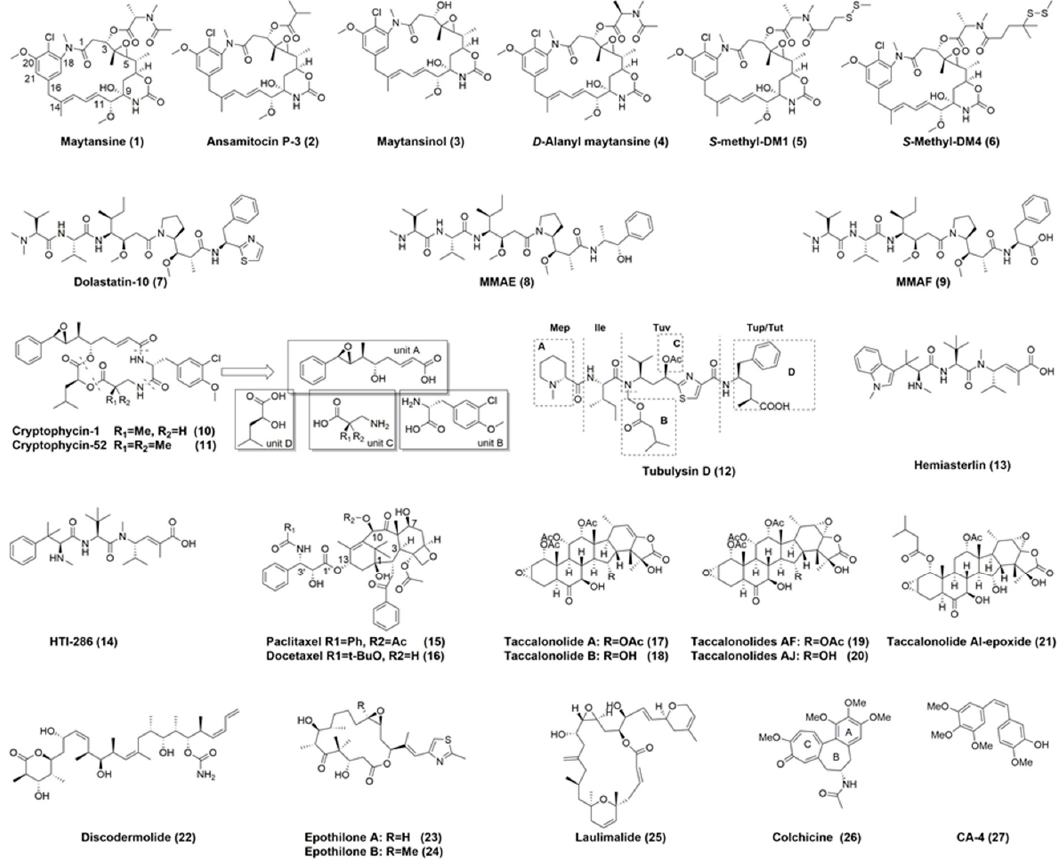
Figure 5. The chemical structures of tubulin inhibitors and their derivatives. Microtubule destabilizers: maytansine and its derivatives, dolastatin-10 and its derivatives, cryptopycin-1, cryptopycin-52, tubulysins D, hemiasterlin and its derivative (HTI-286), colchicine and CA4. Microtubule stabilizers: paclitaxel, discodermolide, taccalonolides A and B and their derivatives (taccalonolide AF and taccalonolide AJ), and taccalonolide AI-epoxide, laulimalide, and epothilones A and B.